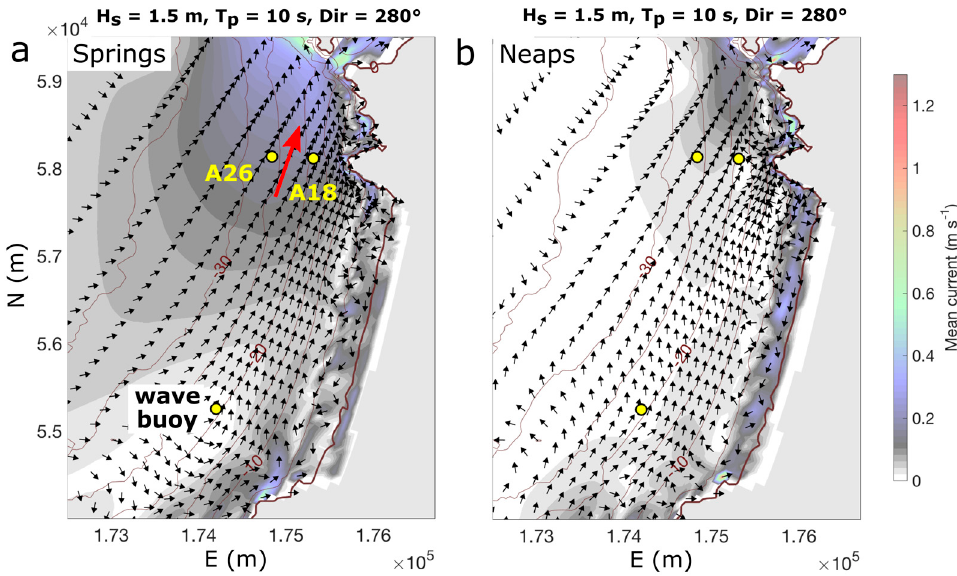
Figure 9. Time-averaged currents under modal conditions, averaged across two tidal cycles, for ( a ) spring tides and ( b ) neap tides. The black arrows indicate current direction, not magnitude.